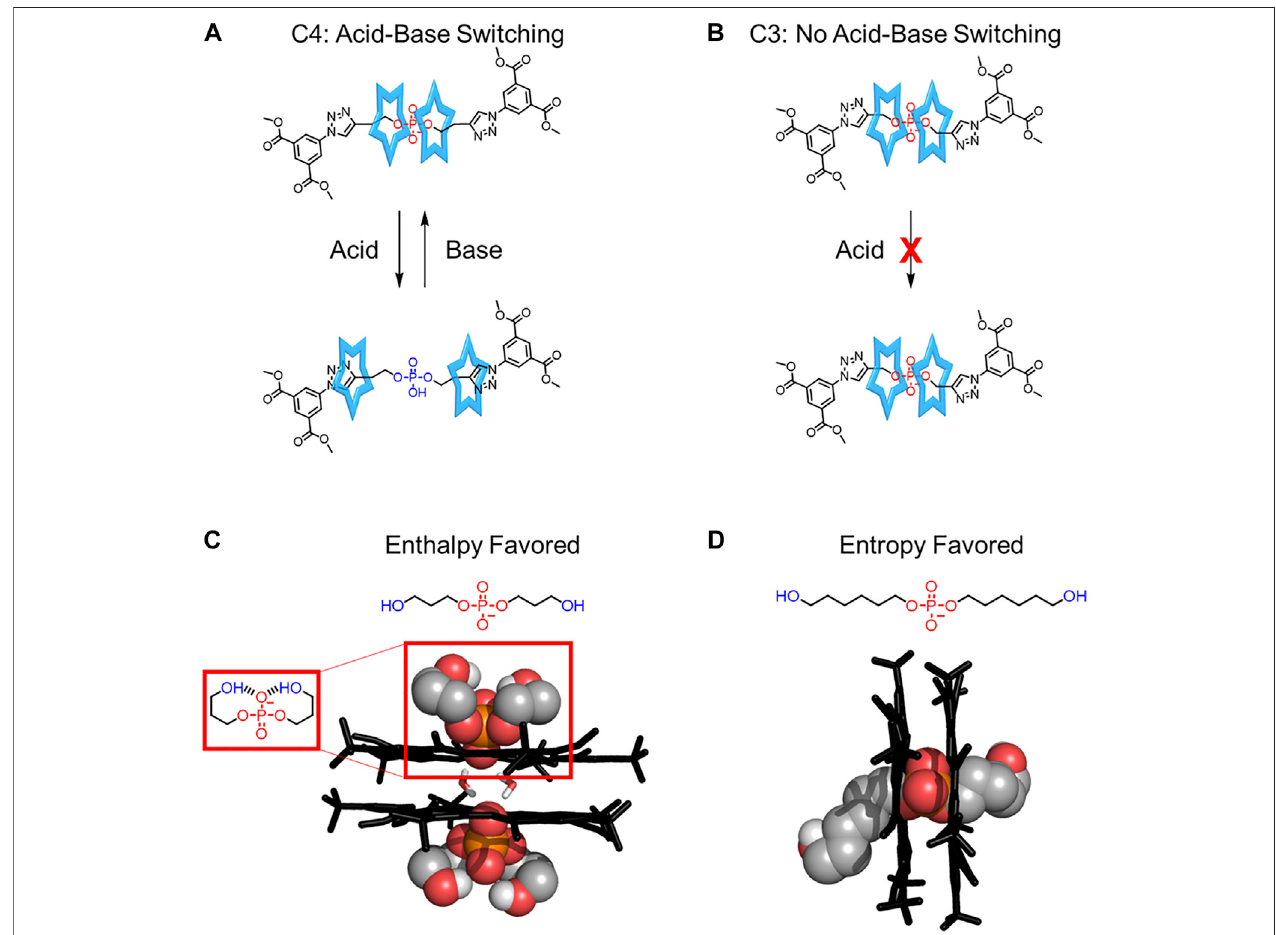
FIGURE 11 | (A) Acid-base switching in a more fl exible rotaxane and (B) the inhibition of switching in a more rigid rotaxane. (C) Crystal structures of the cyanostar complexed with dipropanol phosphate in a backfolded conformation and (D) dihexanol phosphate in a pseudorotaxane.